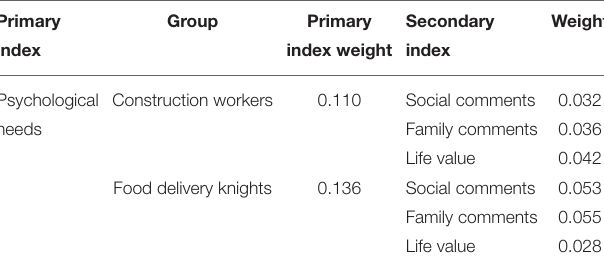
TABLE 9 | Weights of index “psychological needs”.